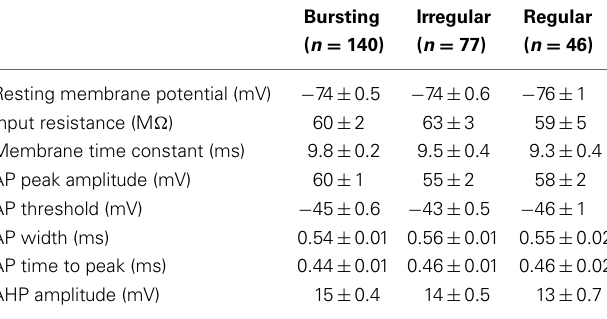
Table 1 | Electrophysiological properties of striatal